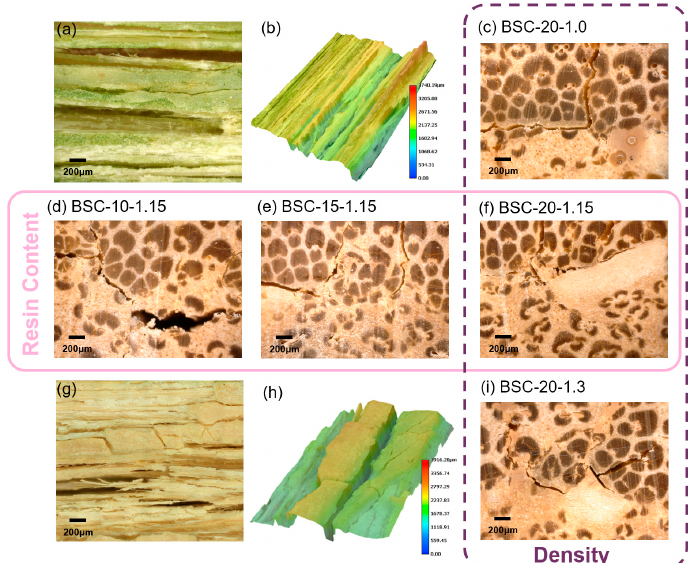
Figure 7. 2D ( a , g ) and 3D ( b , h ) images of the outer ( a , b ) and inner ( g , h ) surfaces of the FBM and failure morphologies at the outer-to-inner bonding interfaces of the BSCs ( c–f , i ) after the 28-h cycle treatment. Note: The pink frame represents BSCs at various resin contents; the purple frame represents BSCs at various densities.